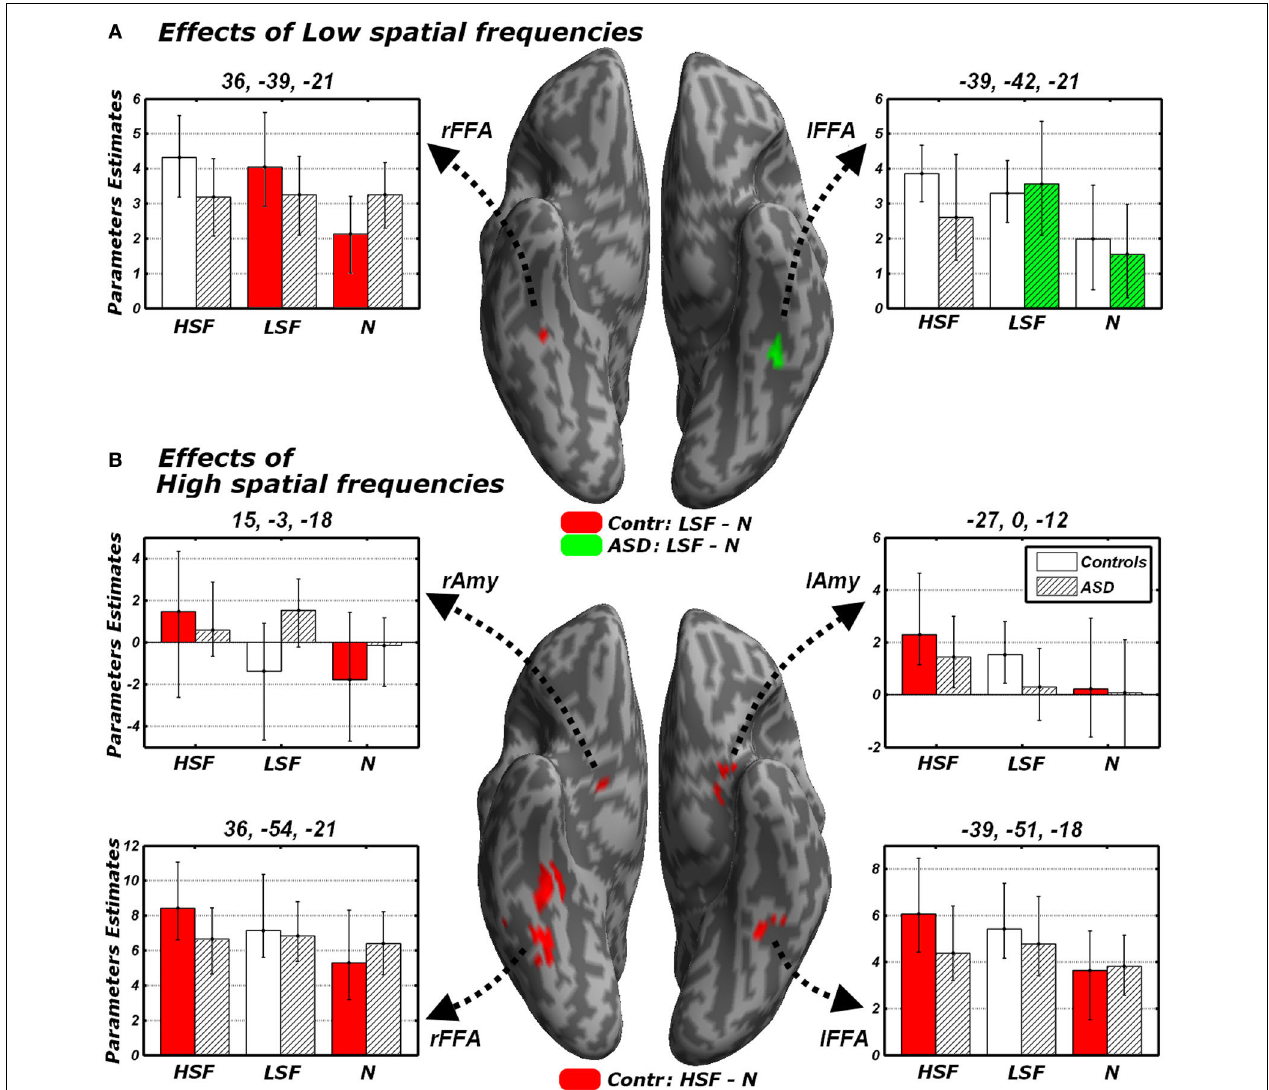
FIGURE 5 | Discrimination task: independent effects of emotional information in either LSF (A) or HSF (B) relative to neutral control stimuli. Whole-brain maps showing significant increase of neural activity associated with (A) the contrast LSF − N or (B) the contrast HSF − N in Controls (red blobs) and ASD individuals (green blobs). Activations are overlaid on an inflated brain surface. Suprathreshold activations were found in